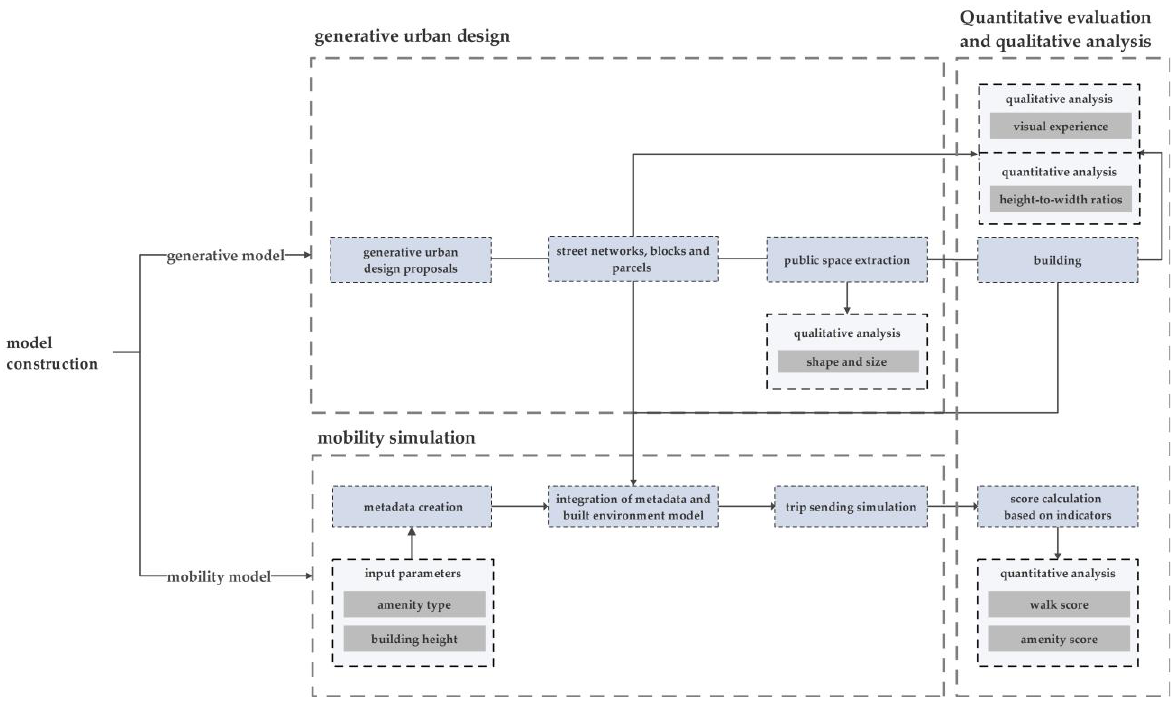
Figure 5. The workflow for quantitative assessment and qualitative analysis of generative design proposals .